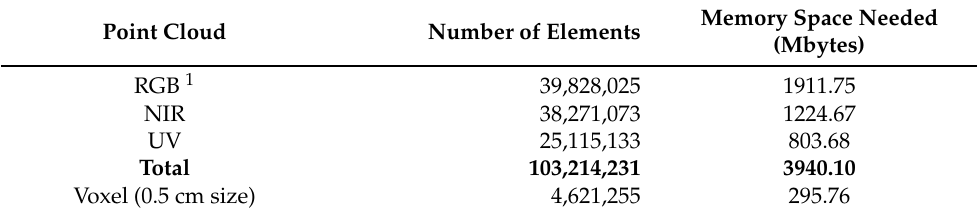
Table 5. Variation of point cloud size in memory with respect to